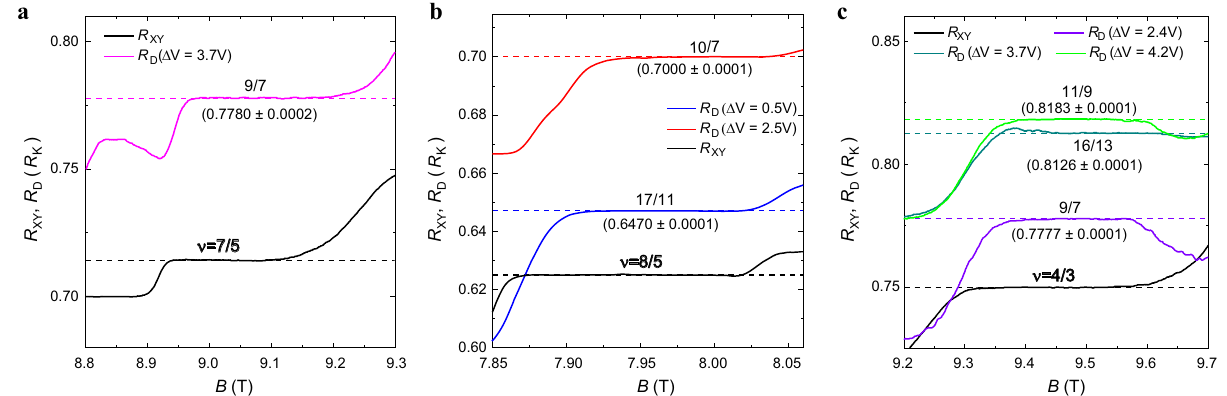
Fig. 2 | Anomalous plateaus at v =7/5, 8/5, and 4/3 states with different gate at different Δ V . The mean values and standard deviations of R D (in a range of at voltages. Black traces represent R XY and traces in other colors represent R D at least0.07Tand110points,dependingontheparticularplateau)arelabelednextto different gating conditions. The annealing voltages are − 5.0V in a , − 4.5V in b , and the plateaus (in the unitof R K ),and dashed linesare guides to the eye. Source data − 5.5, − 5.0, − 5.0Vfrom top to bottom in c .In b and c , R are provided as a Source Data fi le. D exhibits differentplateaus